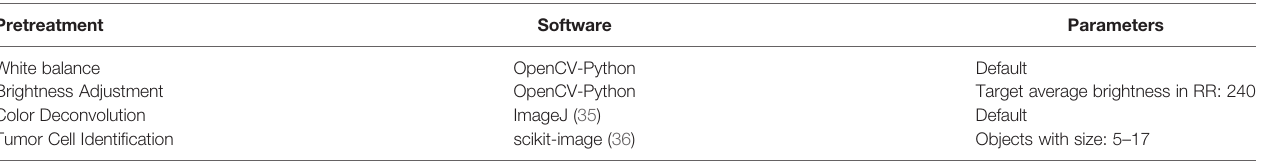
TABLE 1 | Pre-treatment, software, and parameters used in each pre-treatment.